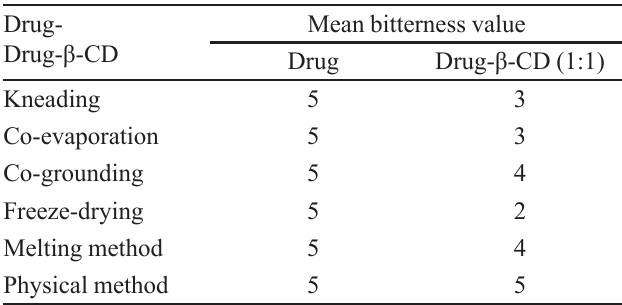
FIGURE 1 - Phase solubility analysis plot for diltiazem hydrochloride inclusion complexes. TABLE II - Taste evaluation of the complexes Drug- Drug-β-CD